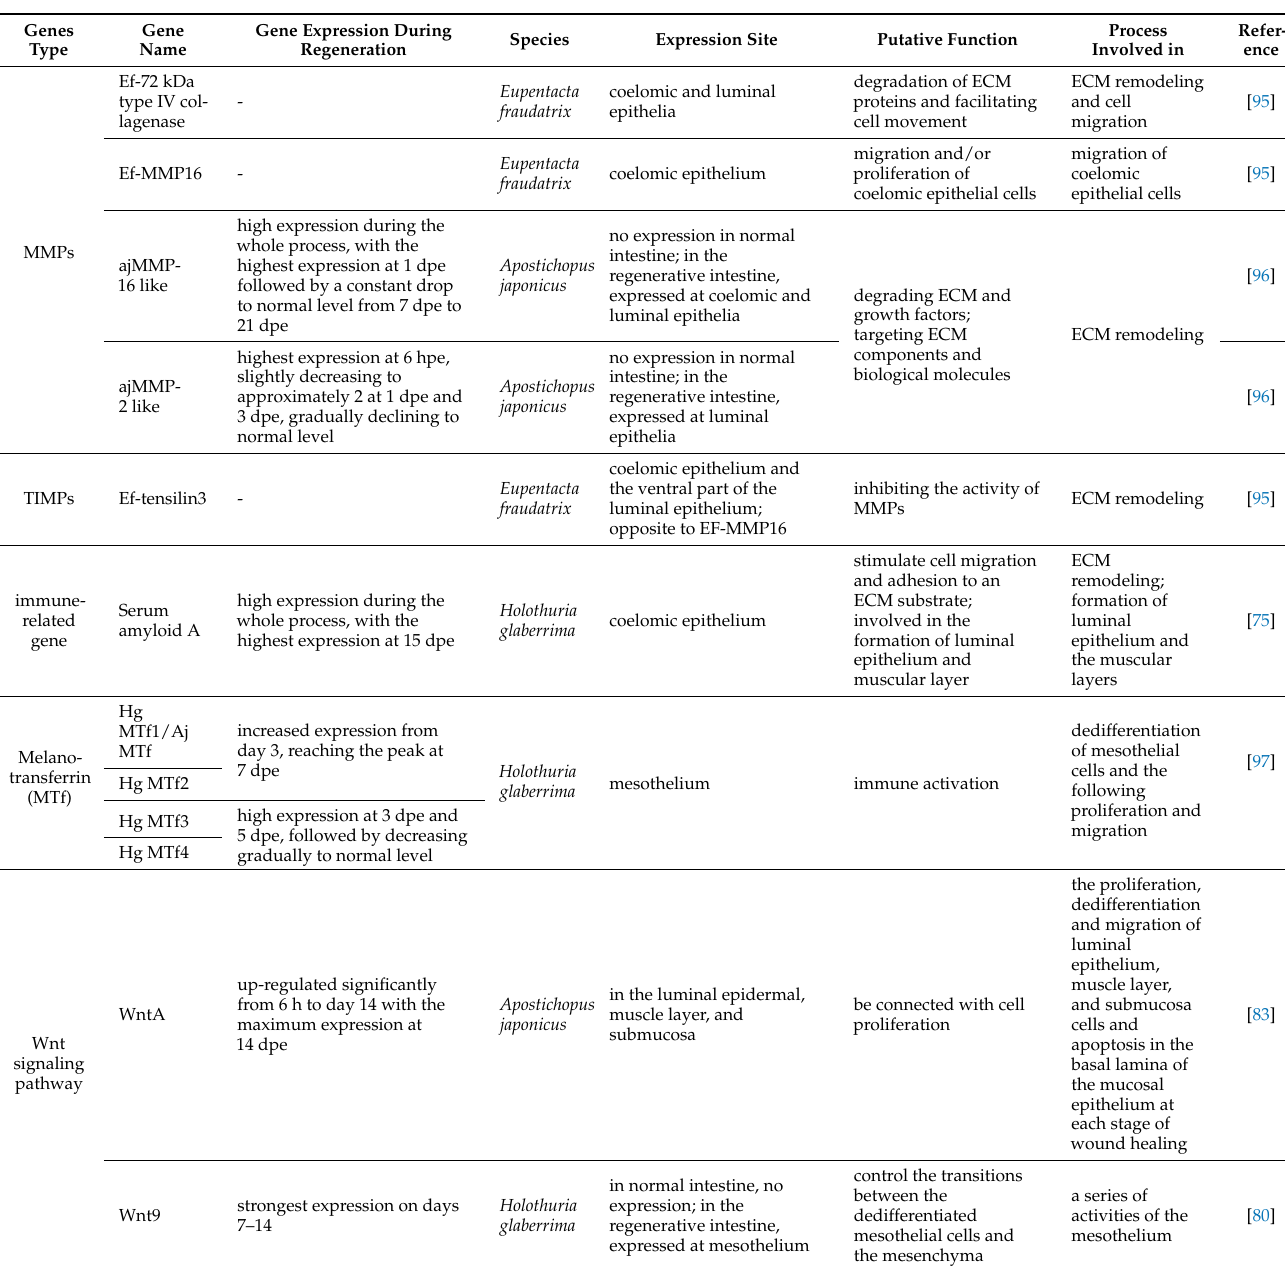
Table 2. Single gene expression patterns during intestinal